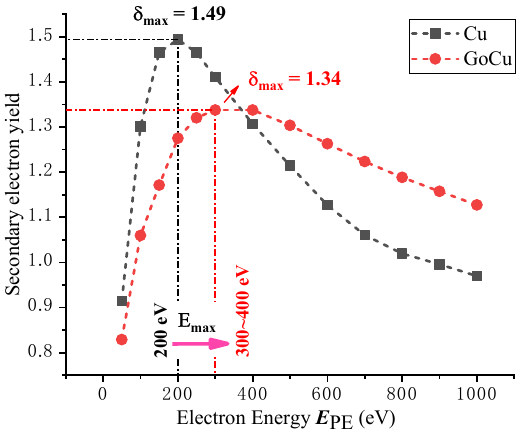
Figure 10. Secondary electron yield from graphene on Cu and Cu.